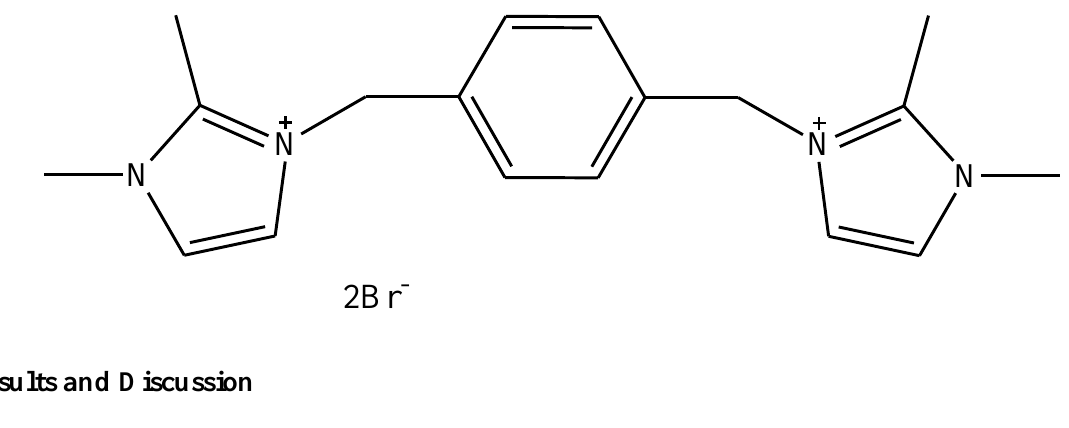
Figure 2. The structure of 1,1’,2,2’-tetramethyl-3,3’-(p-phenylenedimethylene) diimidazolium dibromide (TetraPhimBr).